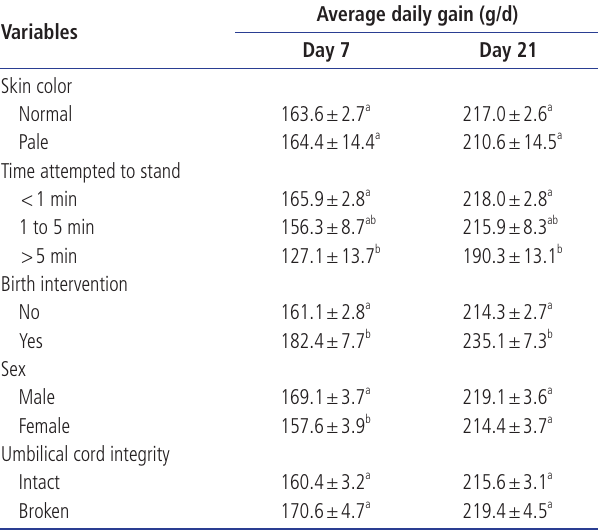
than piglets that attempted to stand within 1 min (218.0±2.8 g/d, p = 0.039, Table 6). Table 6. Categorical variables influencing average daily gain (means±standard error of the mean) at day 7 and 21 after birth from univariate analyses